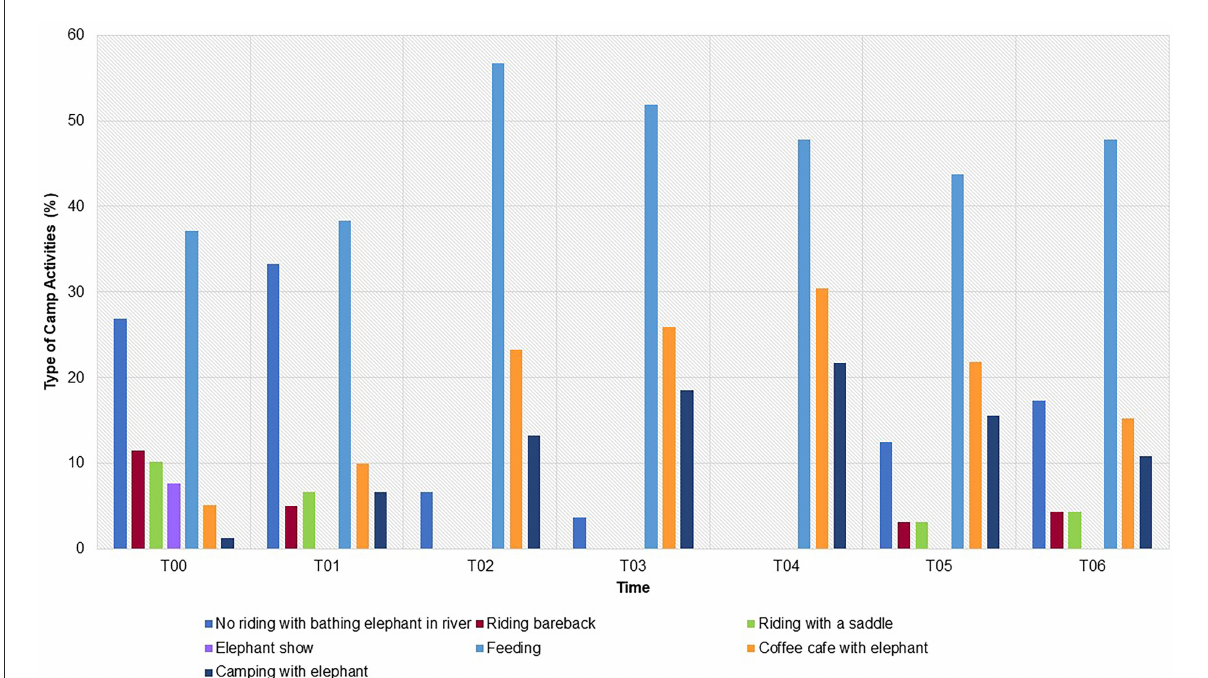
FIGURE3 Changes in tourist activities at elephant camps in northern Thailand before (T00) and through six survey periods [T01 (April–August 2020), T02 (September–December, 2020), T3 (January–April, 2021), T04 (May-August 2021), T05 (September–December, 2021) and T06 (January–April, 2022)] during the COVID-19 pandemic. Data represent the percentage of camps engaged in each activity across time